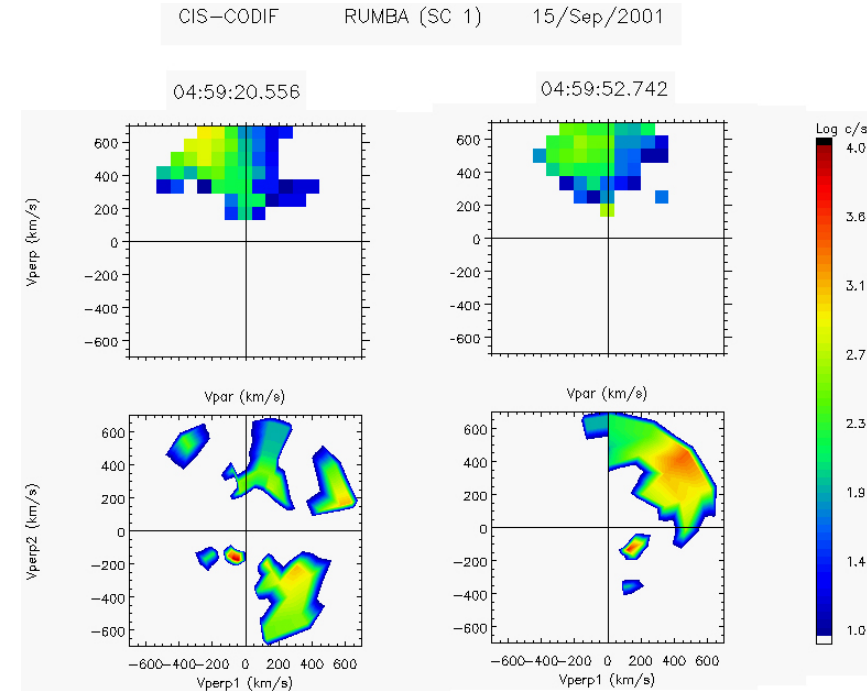
Fig. 7. Distribution functions of oxygen ions in the V || − V ⊥ coordinates from C1 in the bifurcated